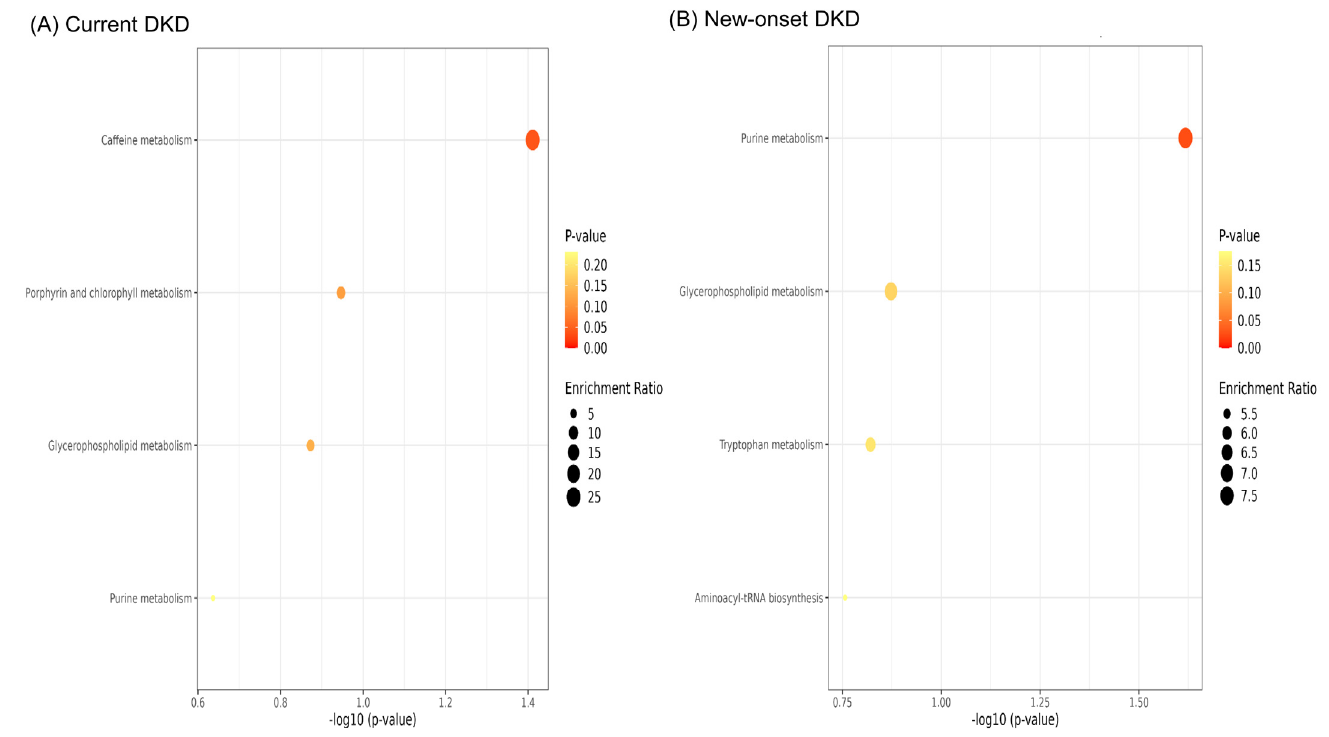
Figure 4. Enrichment analysis of the involved metabolic pathways for significant metabolites in ( A ) current diabetic kidney disease and ( B ) new-onset diabetic kidney disease.